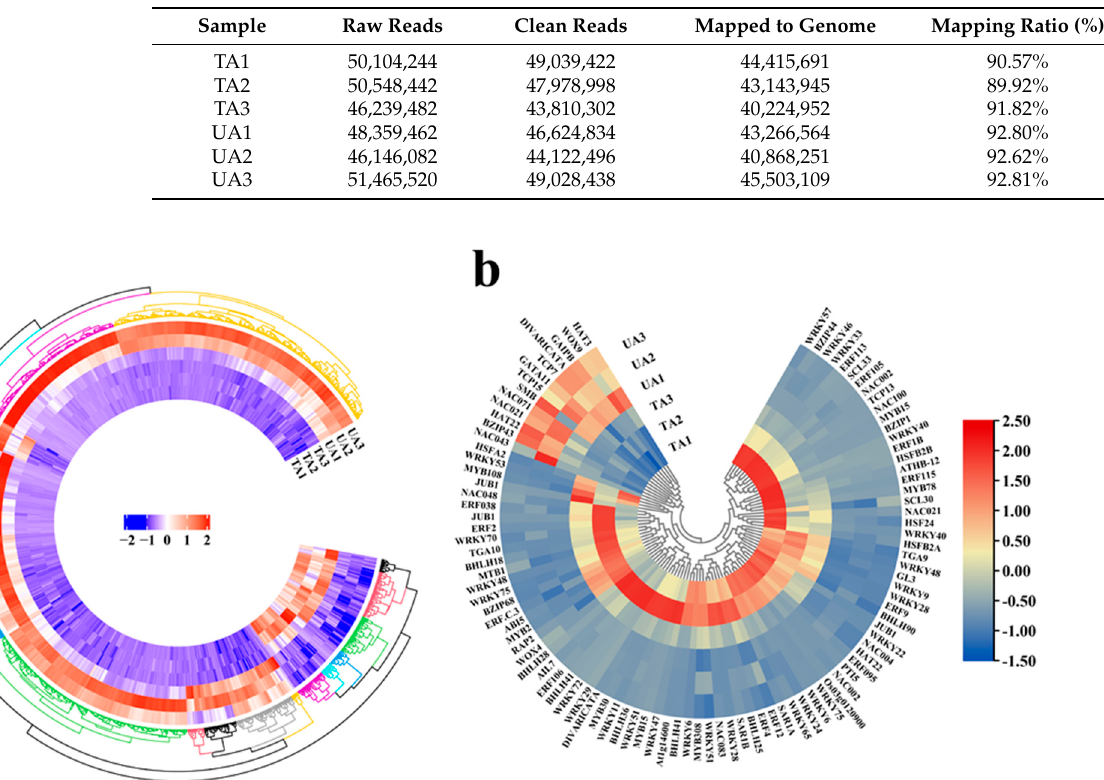
Table 1. Summary of RNA-seq data from treated area (TA) and untreated area (UA).